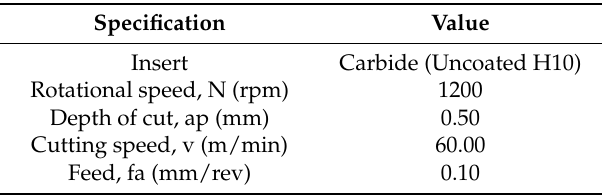
Table 3. Sample machining details.